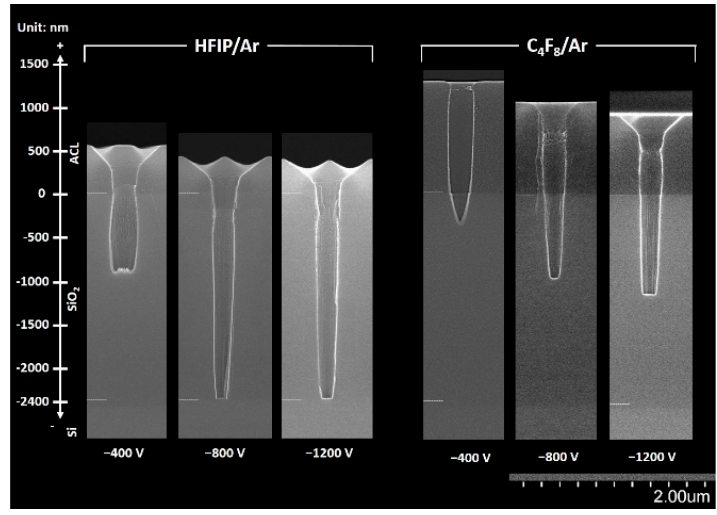
Figure 6. SEM images of the 200 nm diameter SiO 2 contact holes etched in HFIP/Ar and C 4 F 8 /Ar plasmas at various bias voltages.